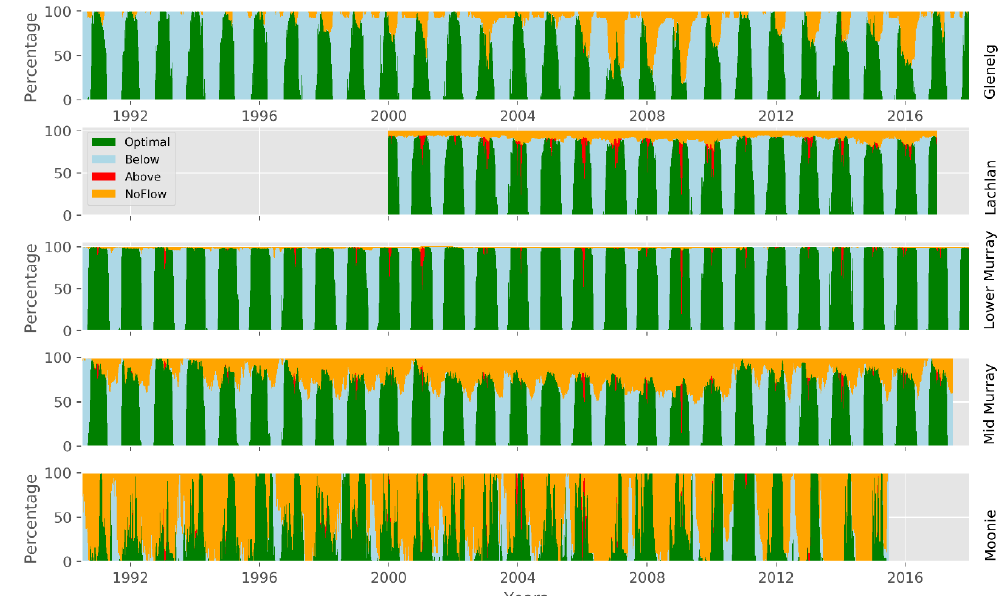
Figure 8. Percentage of reaches with water temperature in the permissible range of virus activity (green), below (light blue), above (red), and where no flow is present (yellow).